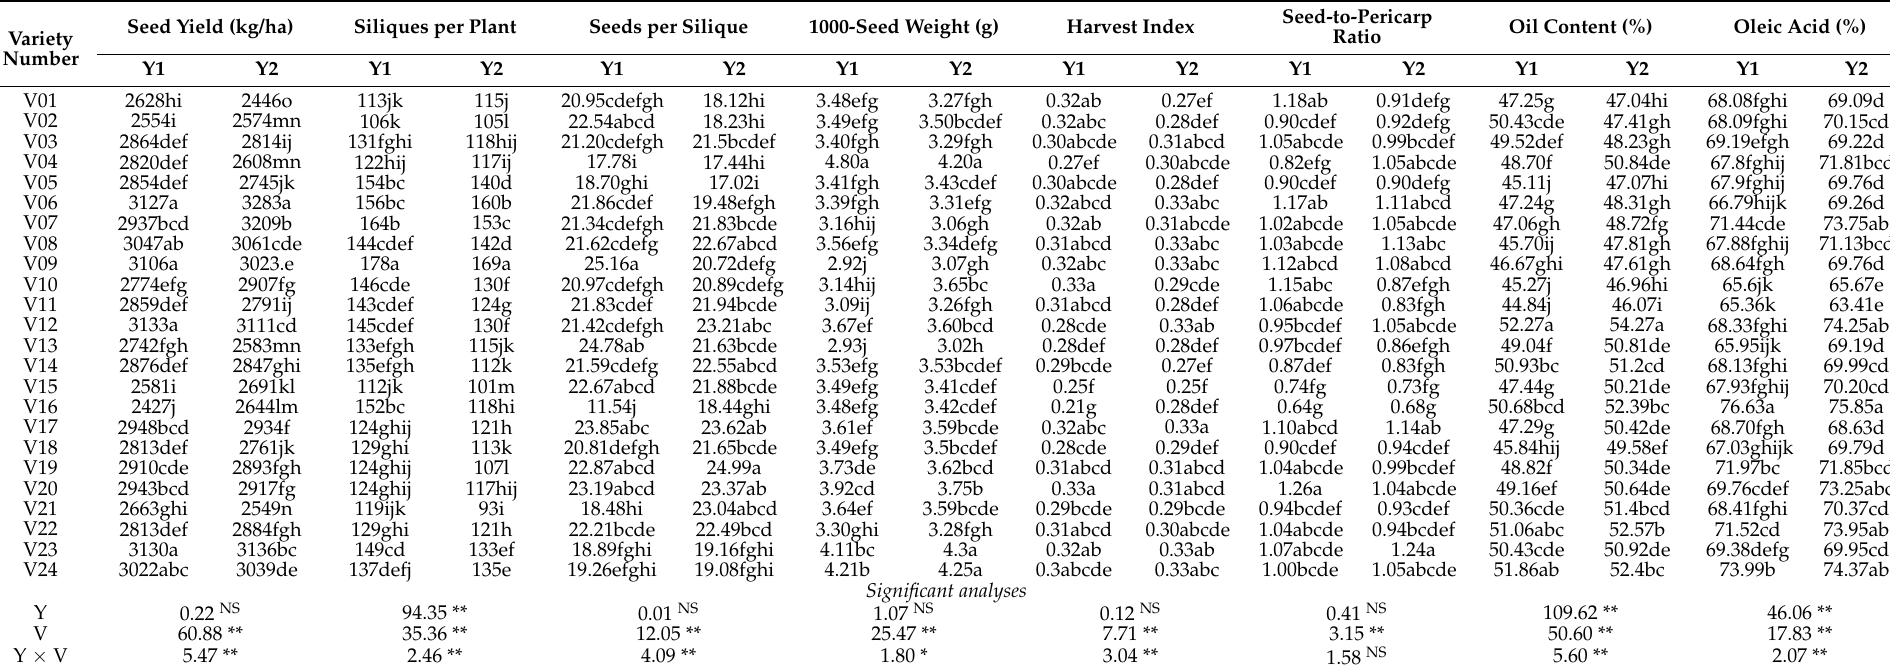
Table 2. Analyses of variance for the seed yield, yield components, and seed